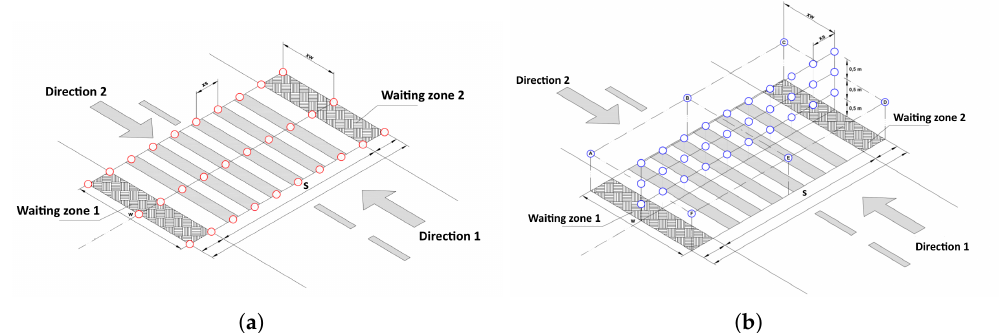
Figure 3. Calculation grids in pedestrian crossing lighting design: ( a ) horizontal grid for calculating E h ; ( b ) two orthogonal grids for calculating E v